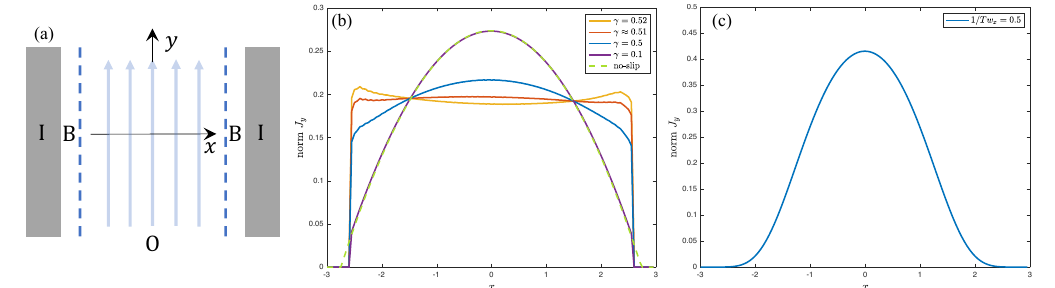
Figure 5: Current flow through a channel geometry with mixed boundary condi- tions. (a): we divide the computational domain into three regions: region I repre- ( x ∈ I ) = 0); region B supports sents the “hard wall” that currents cannot flow ( J i the mixed boundary conditions outside region I; region O denotes the rest domains outside region I. (b): viscous flow pattern along the line y = 0 in region O. Exactly at γ = γ ∗ ≈ 0.51, the current profile becomes flat corresponding to the no-stress bound- ary condition. Above γ ∗ , the current profile will quickly diverge whenever γ (cid:166) 0.56; while below γ ∗ , the distribution evolves from flat to parabolic pattern. The dashed line is calculated with the no-slip boundary condition introduced in the main text, i.e. in the absence of region B, and it coincides with the results of γ → 0. The difference between the dashed and solid lines in their tails is due to the finite width of region B. (c): the quantum critical flow pattern remains fixed under the mixed boundary